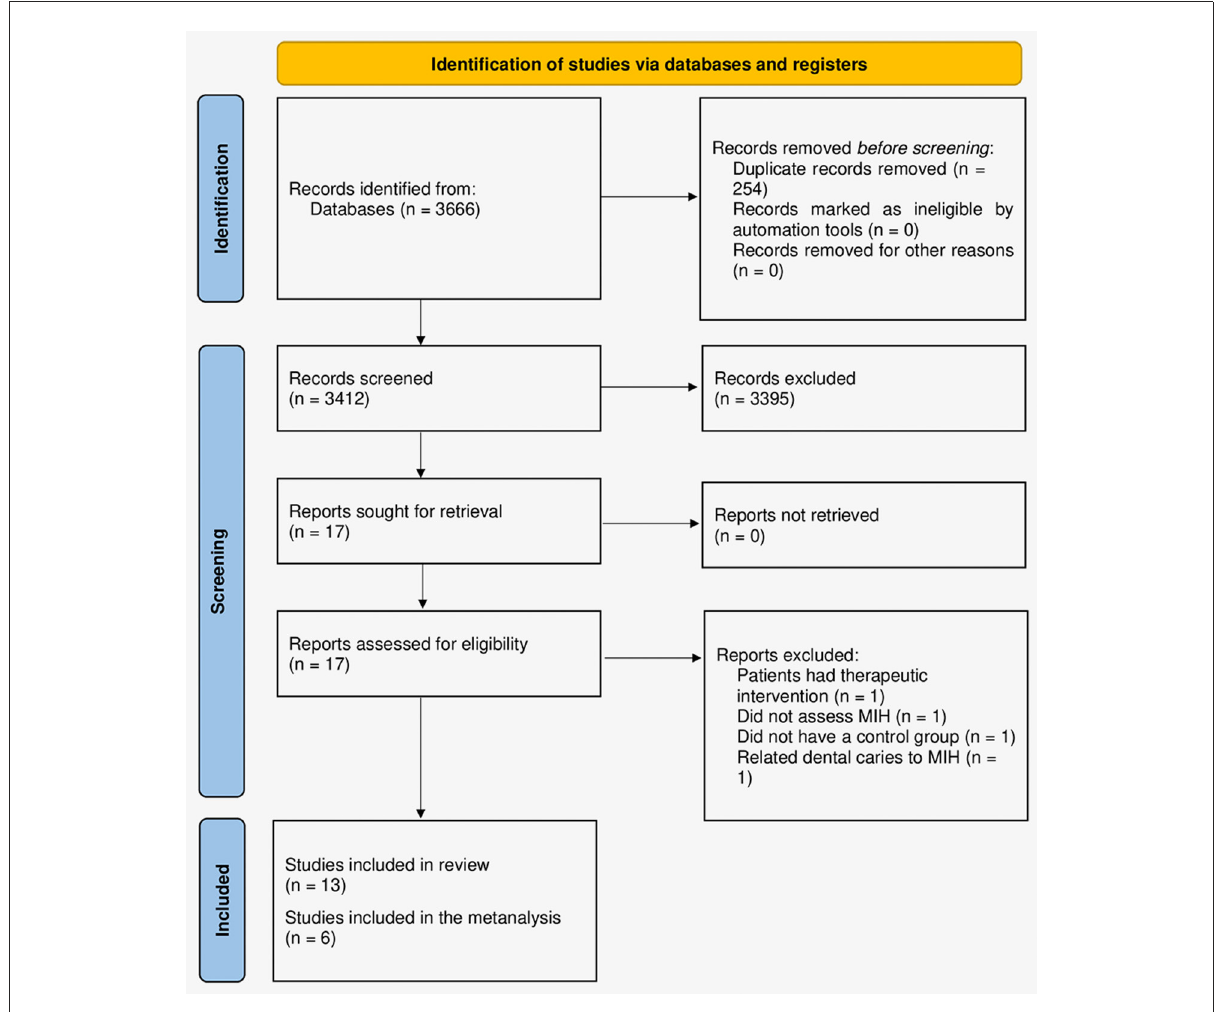
FIGURE1 Flowchart of the study selection process according to the PRISMA protocol